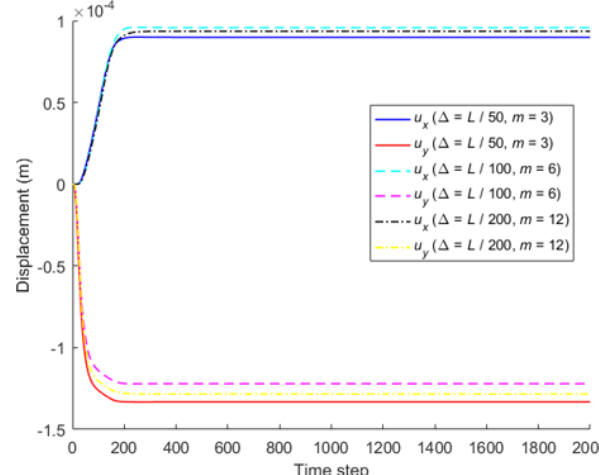
Figure 5. m - convergence of displacement with time step at different nodes. Figure 5. m -convergence of displacement with time step at different nodes.